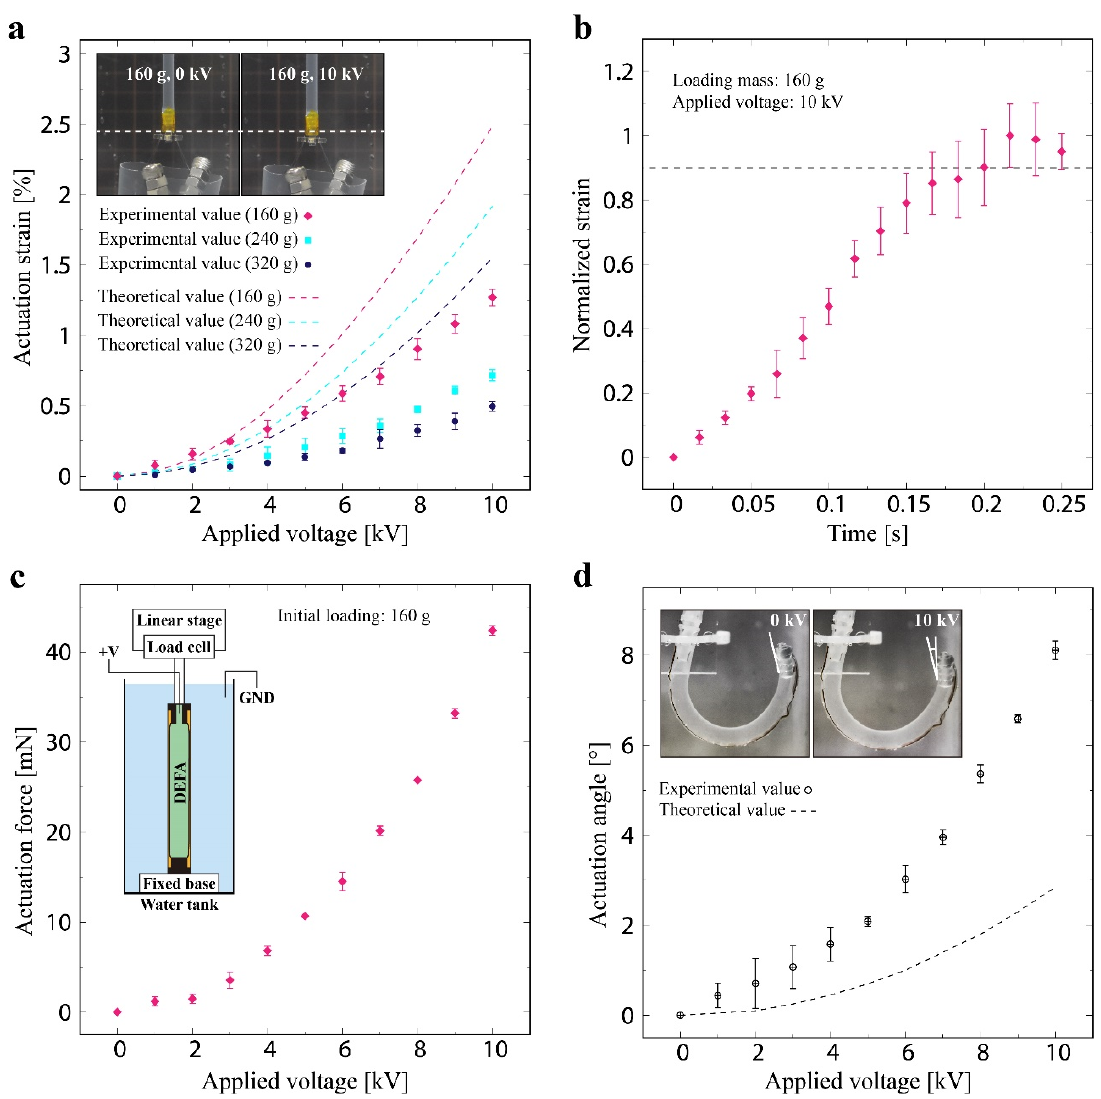
Figure 4. ( a ) Actuation strain of the linear-type DEFA as a function of the applied voltage. ( b ) Response time of the linear-type DEFA (loading mass of 160 g, applied voltage 10 kV). ( c ) Actuation force as a function of the applied voltage. ( d ) Actuation angle of the bending-type DEFA as a function of the applied voltage.